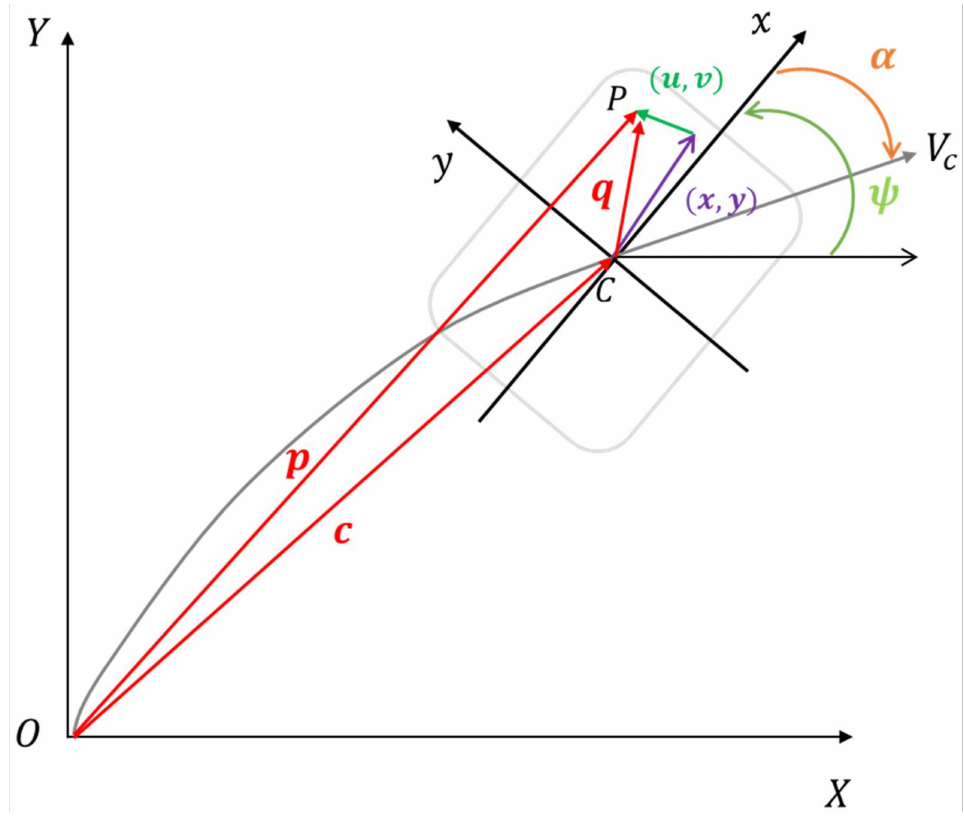
Figure 1. Top view of tire contact area and its deformations ( u , v ) with respect to ( C , x , y , z )